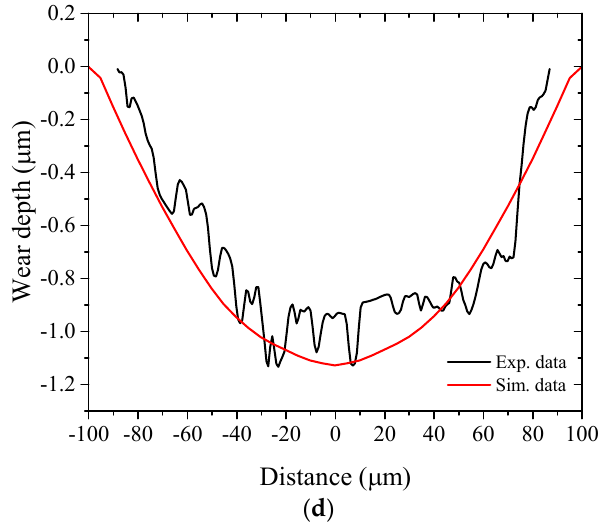
Figure 7. ( a ) Schematic view of the fretting wear experiments, ( b ) surface morphology of the fretting wear scar, ( c ) surface height measured along the A-B section, and ( d ) comparison between the predicted and experimental wear scar profiles after 12,000 cycles.